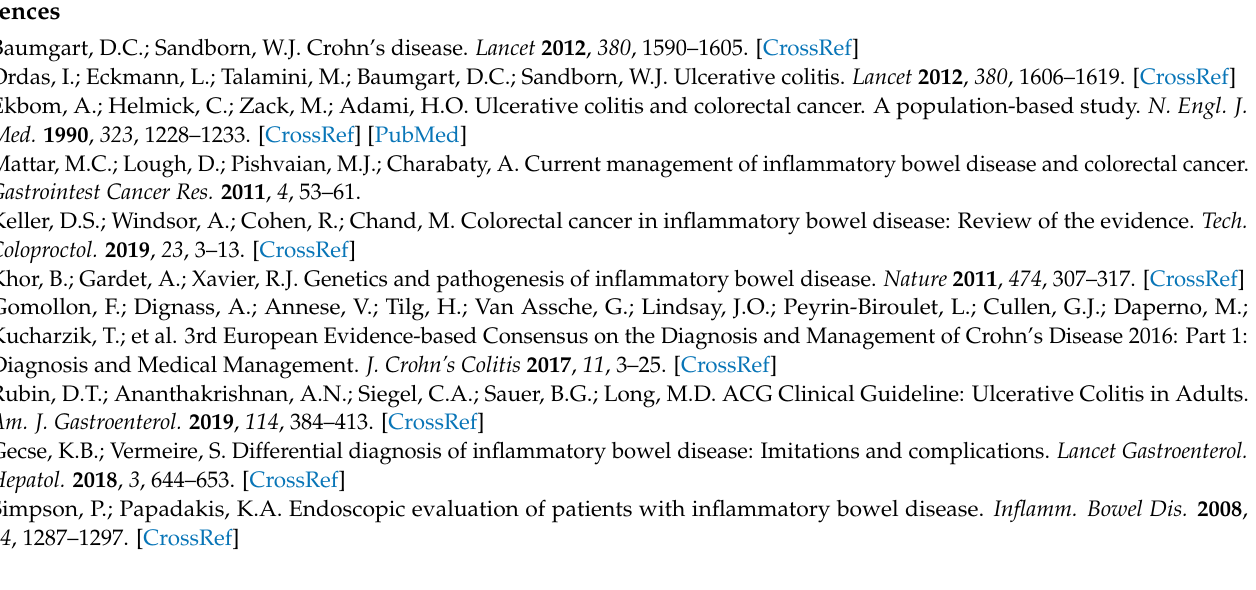
Table 1. We also appreciate the S. Karger AG, Basel publishers for reusing the Figure for our review’s Figure 2 from the journal Digestive Diseases (2021; 39: 190–203,